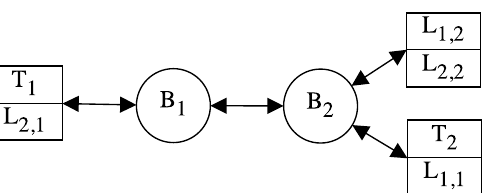
Figure 1. Example of a TSN-based network with three end-systems and two bridges. Two end- systems act as talker and listener and the third one acts as listener of two